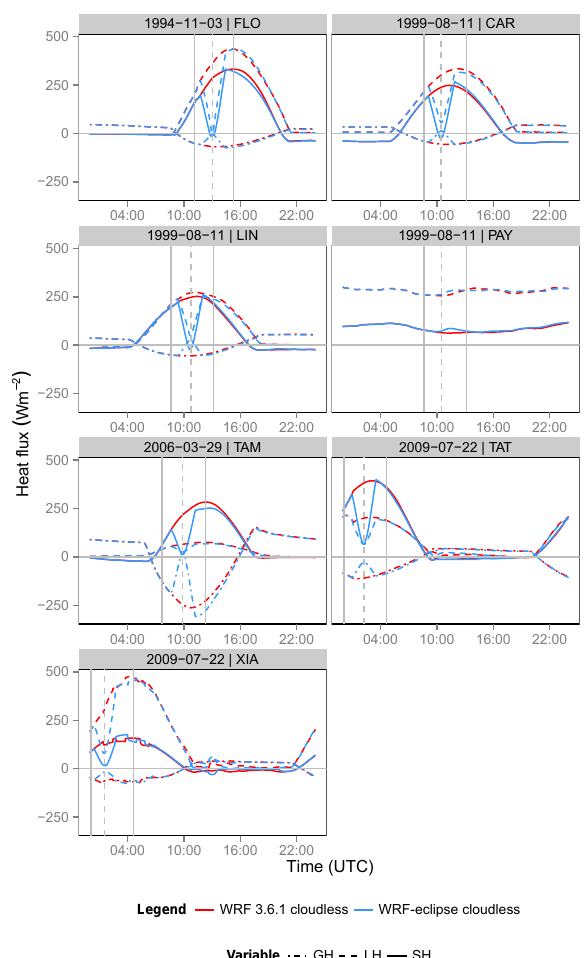
Figure 4. Sensible heat (SH), latent heat (LH) and ground heat (GH) flux outcomes for each episode and site. Each total solar eclipse event is labeled with the date. The GH in PAY is not plotted because the nearest point used is represented by a water body (i.e., GH un- defined). Colors indicate the control simulation outcomes (red) and the new implementation (blue). The first and second vertical gray solid lines indicate the time of FCTD and LCTD, respectively. The dashed vertical gray line shows the time of maximum obscuration. All results are expressed with 1min time